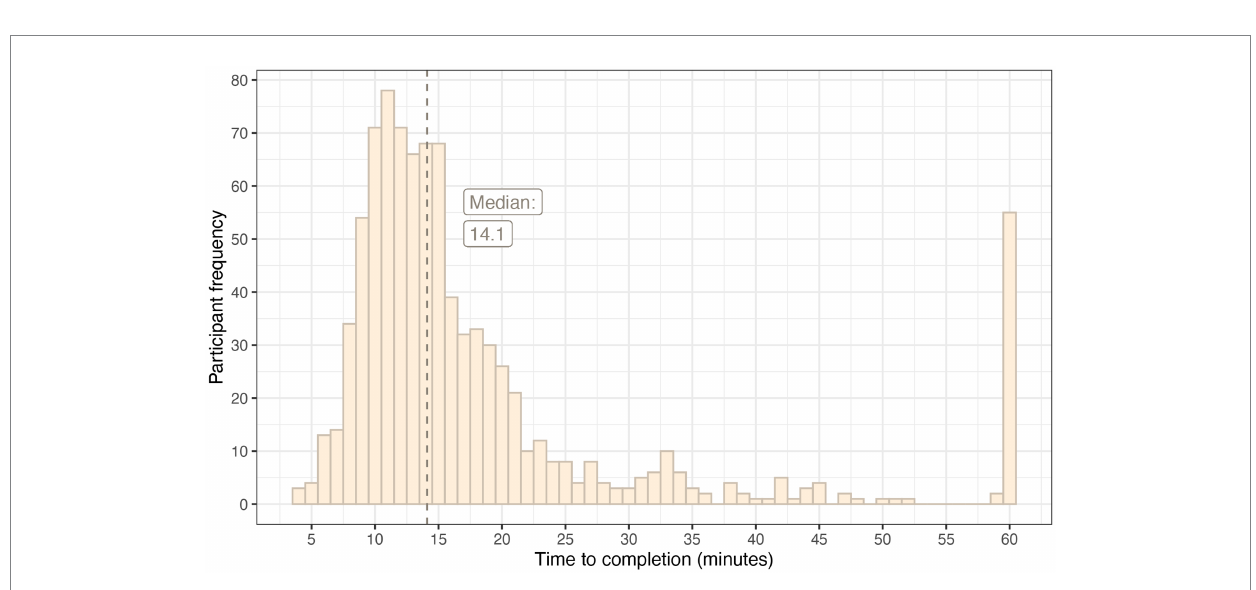
FIGURE 4 A histogram demonstrating the distribution of response times for the